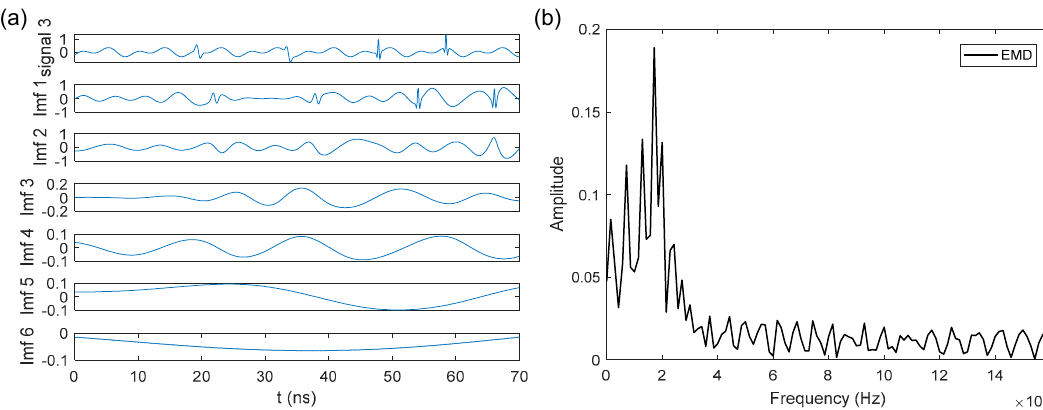
Figure 4. ( a ) The denoised results of the synthetic signal using empirical mode decomposition filtering (EMD); ( b ) the corresponding amplitude spectrum of Imf 1.